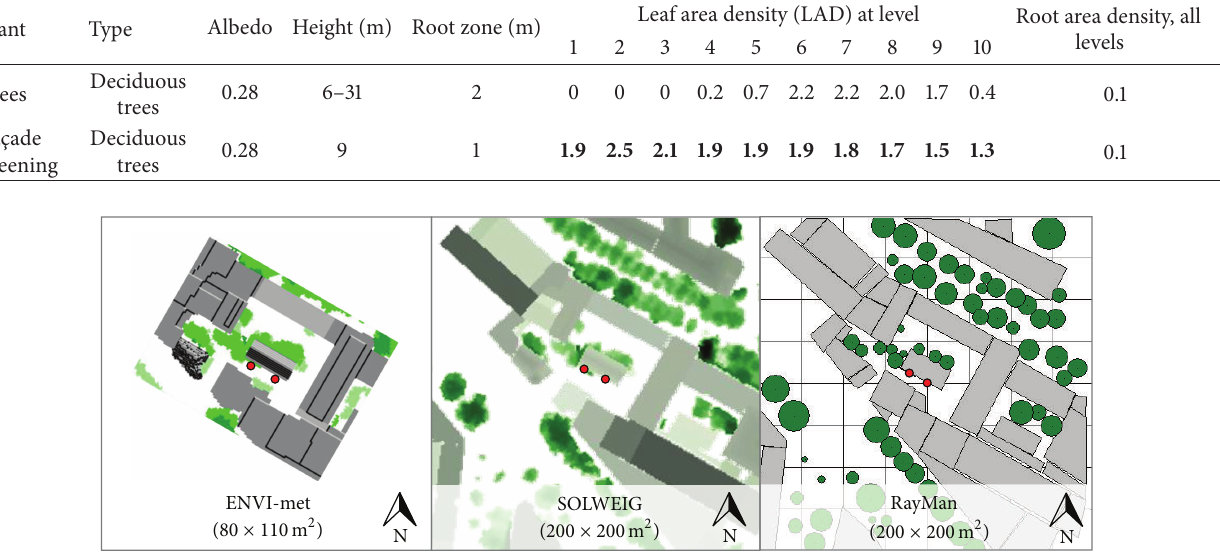
Figure 3: Model domains of the different models. In the domain of SOLWEIG, dark colors represent taller buildings and vegetation compared to pale colors. Red circles indicate the greened and the bare site of observation and